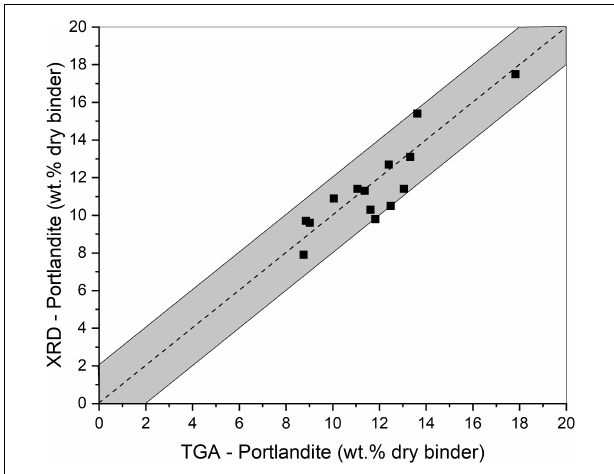
FIGURE 9 | Correlation plot of XRD-Rietveld vs. TGA results for portlandite content. The dashed line represents the 1:1 correlation, the gray area indicates a 2% error margin.